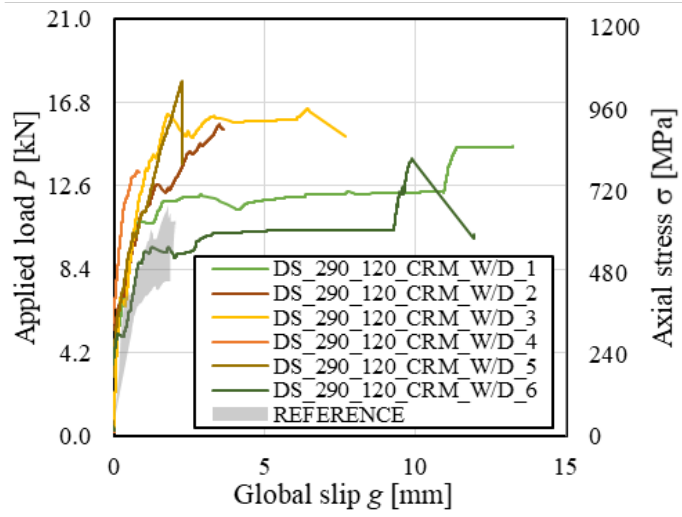
Figure 15. P-g responses of CRM-masonry joints. Conditioned specimens generally showed higher peak loads than reference speci- mens. The average peak stress increased by 47% from reference to conditioned specimens (Figure 7), with a similar CoV (CoV = 11.7% and 9.7% for reference and conditioned speci- mens, respectively). This effect was attributed to curing of the lime-based mortar induced by wet–dry cycles. The mechanical properties of the conditioned matrix increased the slope of the initial linear branch of P - g curves and provided a better matrix-grid interlocking, thus increasing the peak load